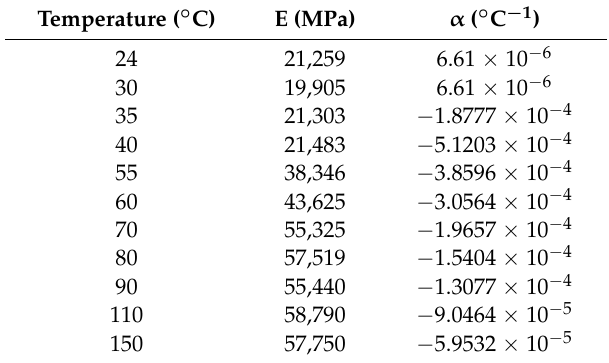
Table 2. SMA temperature-dependent mechanical and thermal